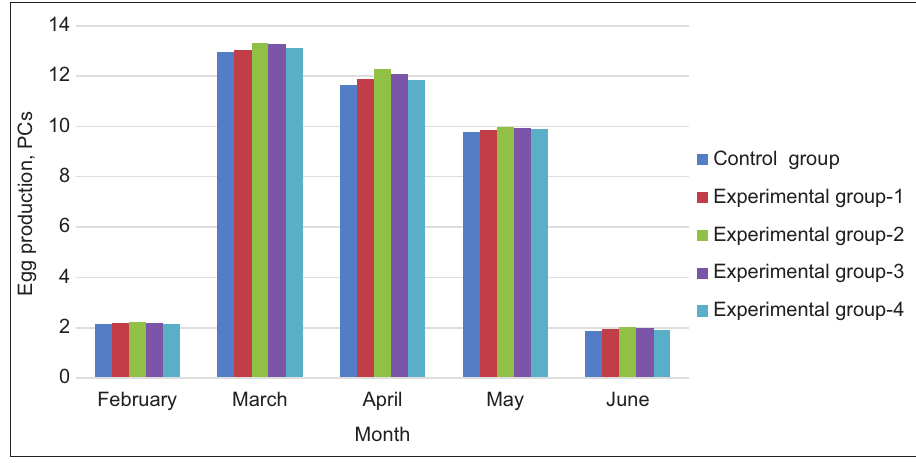
Figure-2: Geese egg production